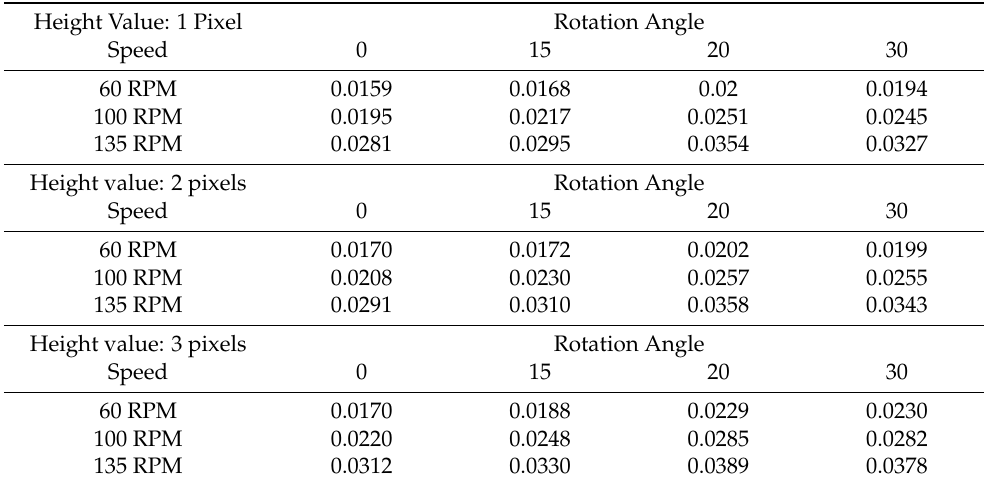
Table 6. Synthetic radial motion blur